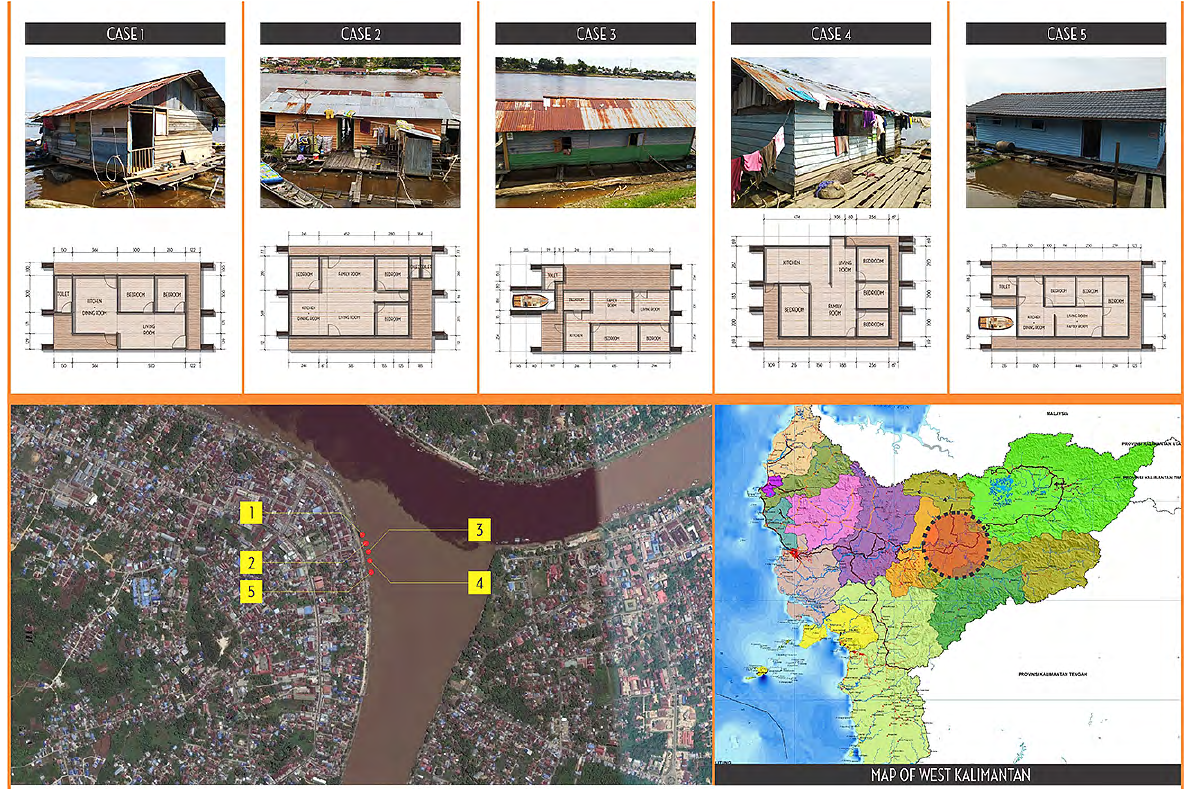
Figure 6. Location and research